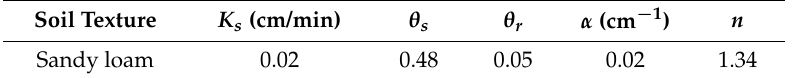
Table 3. Soil water characteristic